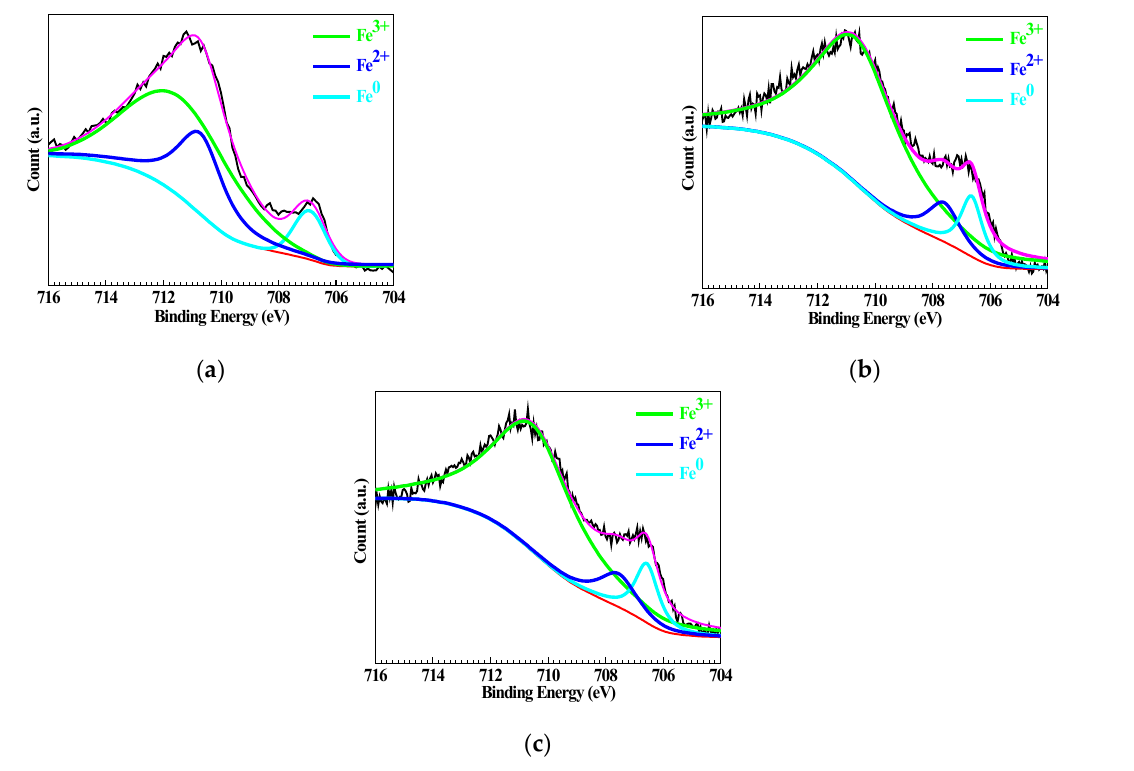
Figure 7. High-resolution XPS of Fe 2p for Q235 samples polarized to E p in WO 4 2− + Cl − , MoO 4 2− + Cl − and WO 4 2− + MoO 4 2− + Cl − solutions: ( a ) WO 4 2− + Cl − solution, ( b ) MoO 4 2− + Cl − solution and ( c ) WO 4 2− + MoO 4 2− + Cl − solution.